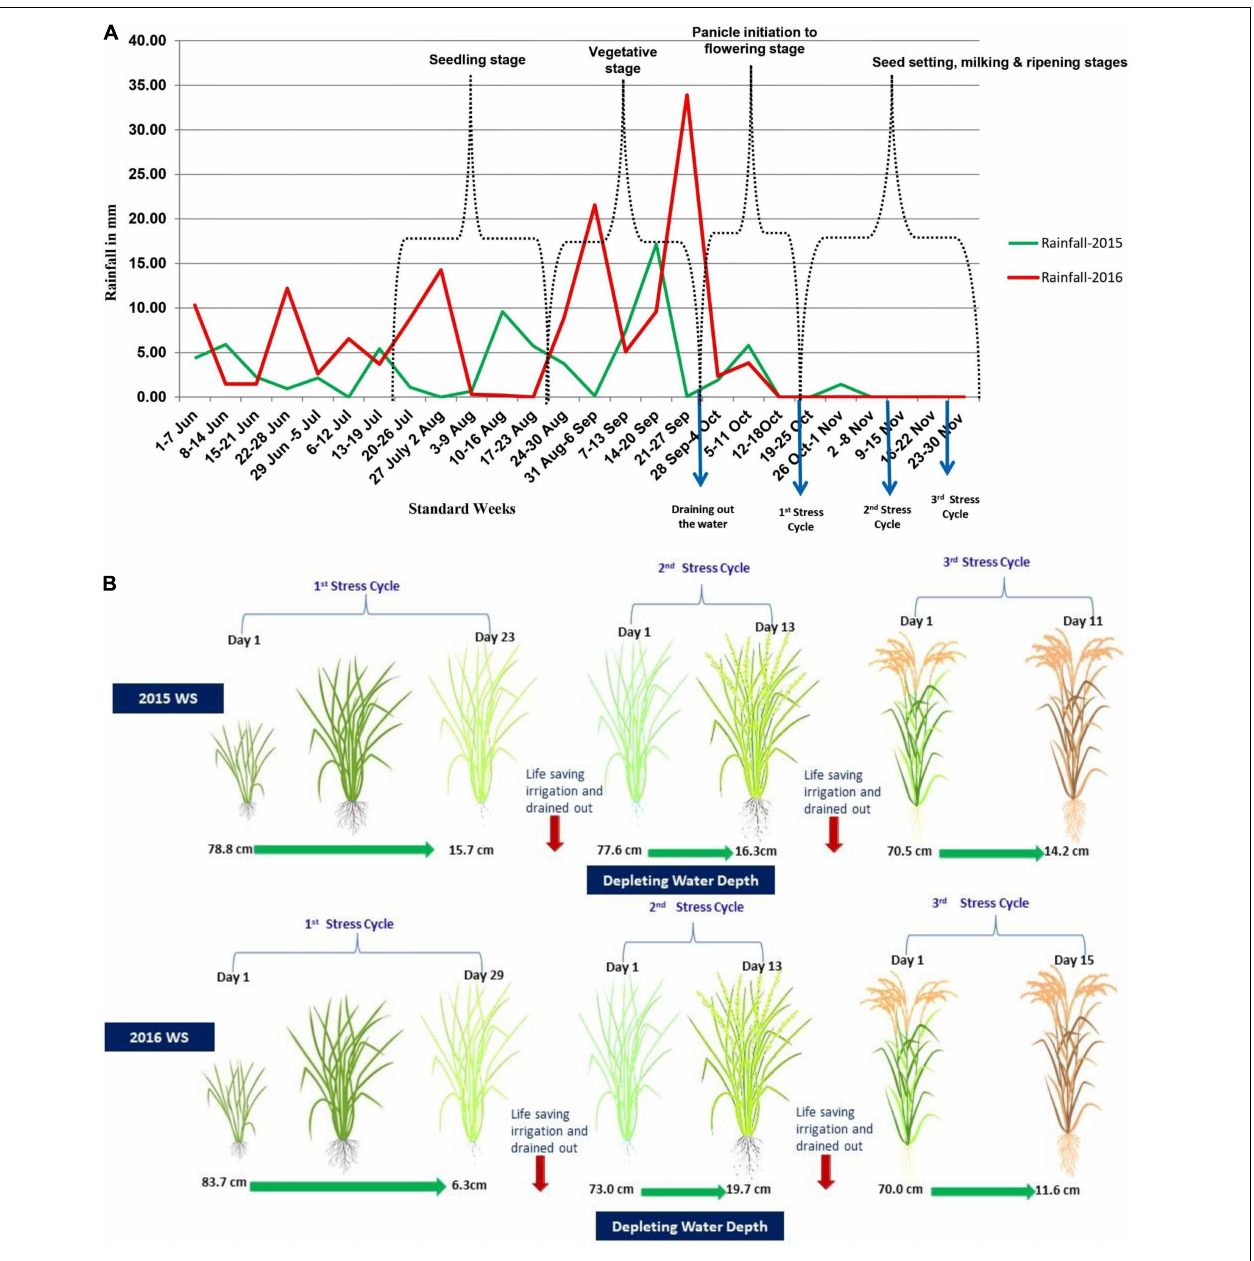
FIGURE 1 | (A) Weekly rainfall pattern in the wet seasons of 2015 and 2016 at IRRI, Hyderabad, India. (B) showing water table content of the stress-imposed field in both seasons of 2015 WS and 2016 WS.